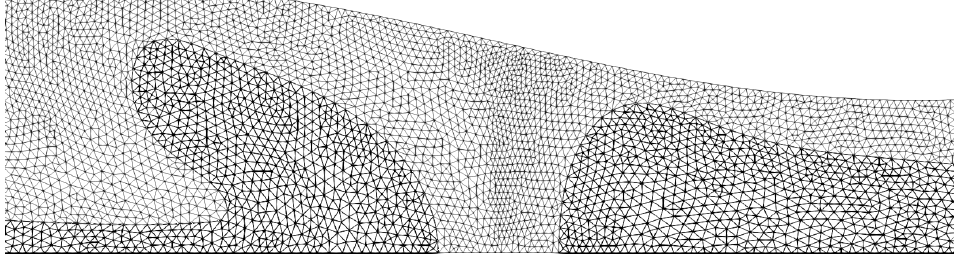
Figure 3. Unstructured triangle finite element mesh detailed of slug flow in sinusoidal channel. This figure illustrates, in detail, the resulting mesh during the corrugated channel passage of two sequential drops. The left hand side drop is deformed during the convergent section, while the right hand side is stretched out when passing by the convergent section. Black lines of triangles represent the inner region (drops) and the others stand for the outer region (suspending